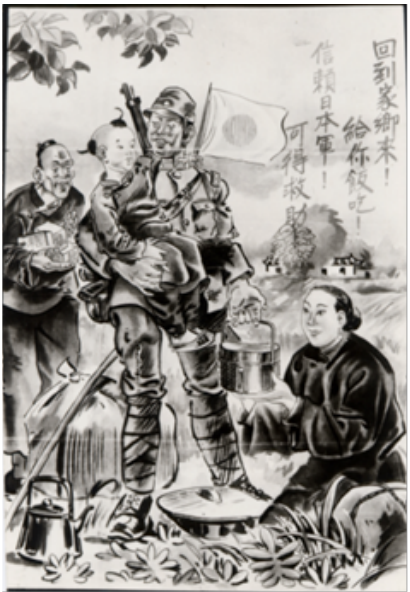
Figure 14. Japanese propaganda in China. Source: Unknown